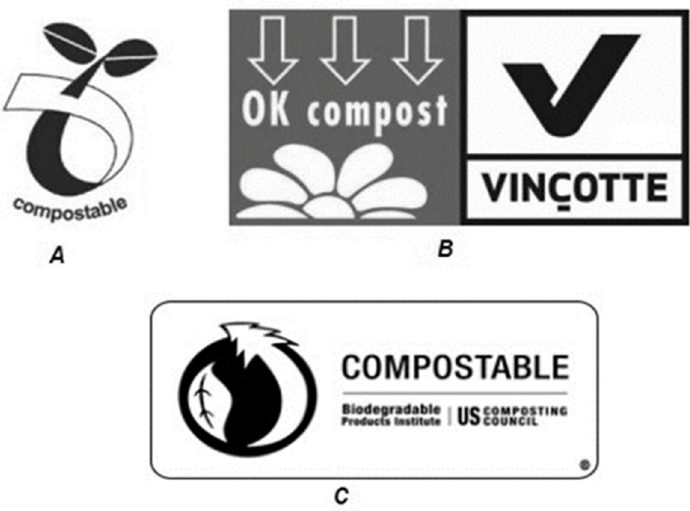
Figure 2. Examples of Logos certifying a material’s compostability in EU countries: The ( A ) “Seedling” and ( B ) “OK compost” logos are issued by DIN CERTCO and Vincontte, and ( C ) the “compostable” logo is issued by the Biodegradable Plastic Institute in the U.S. Sources: [21].